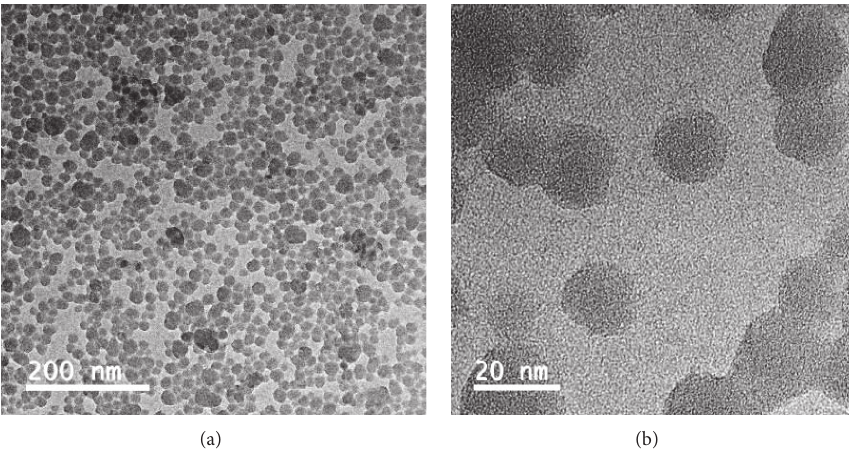
Figure 4: TEM of nanosilica: (a) 200 nm silica TEM picture; (b) 20 nm silica TEM picture.